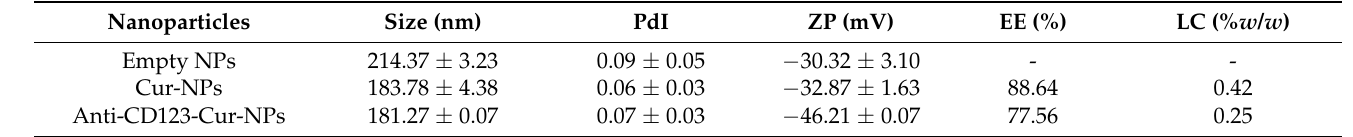
Table 1. Characteristics of the